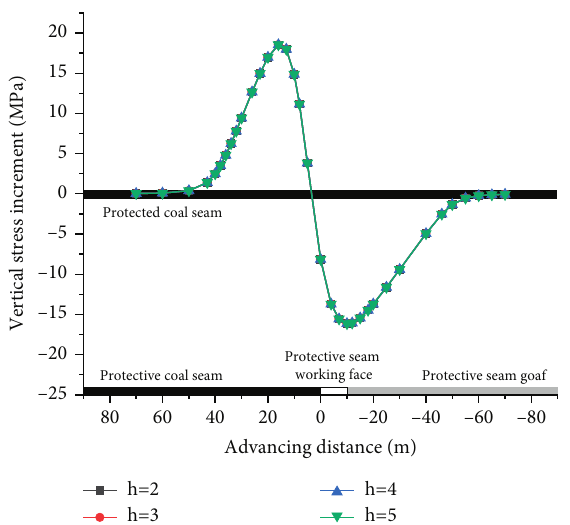
Figure 8: Stress variation curves of different coal thicknesses in the protected